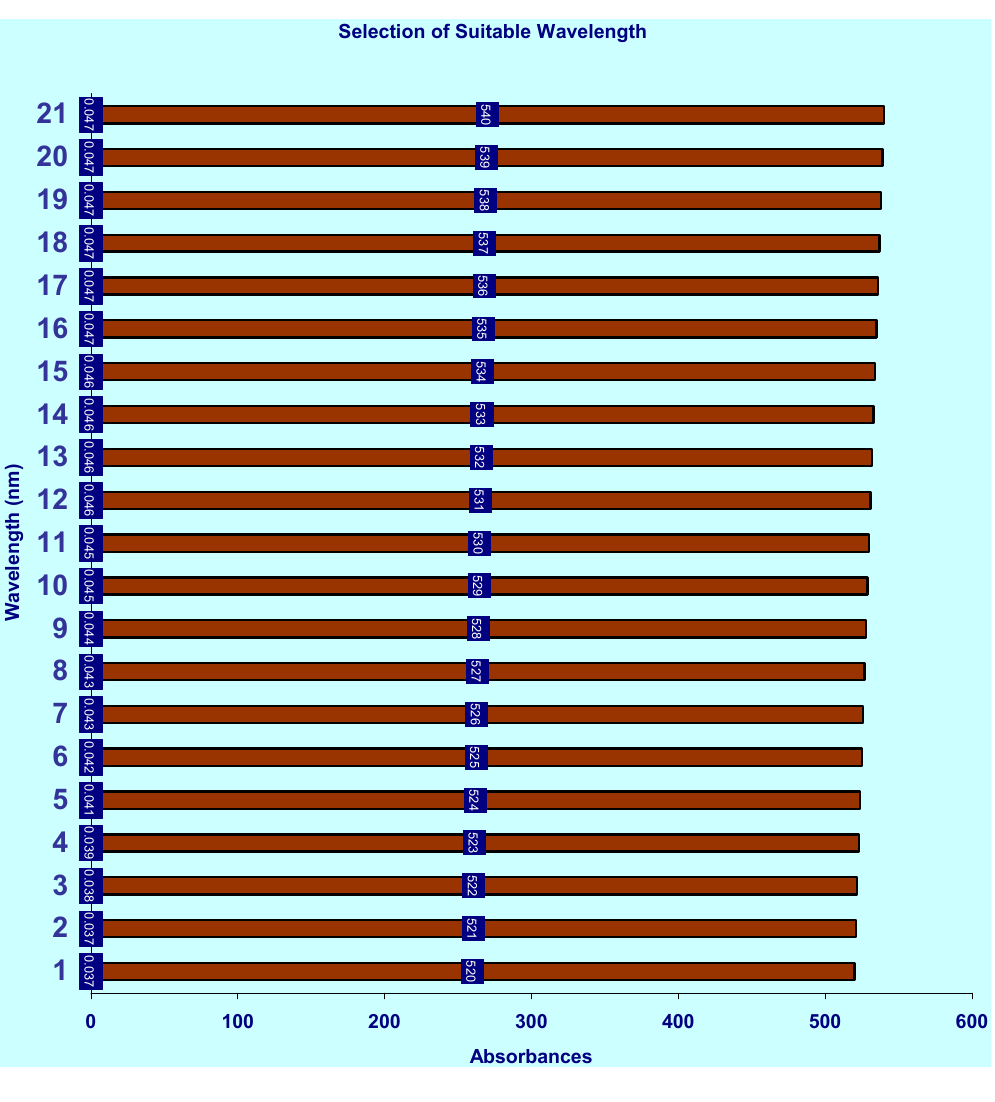
Figure 4. 0.45ppb arsenic standard at di ff erent wavelengths. Figure-4: 0.45 ppb Arsenic Standard at Different Wavelength